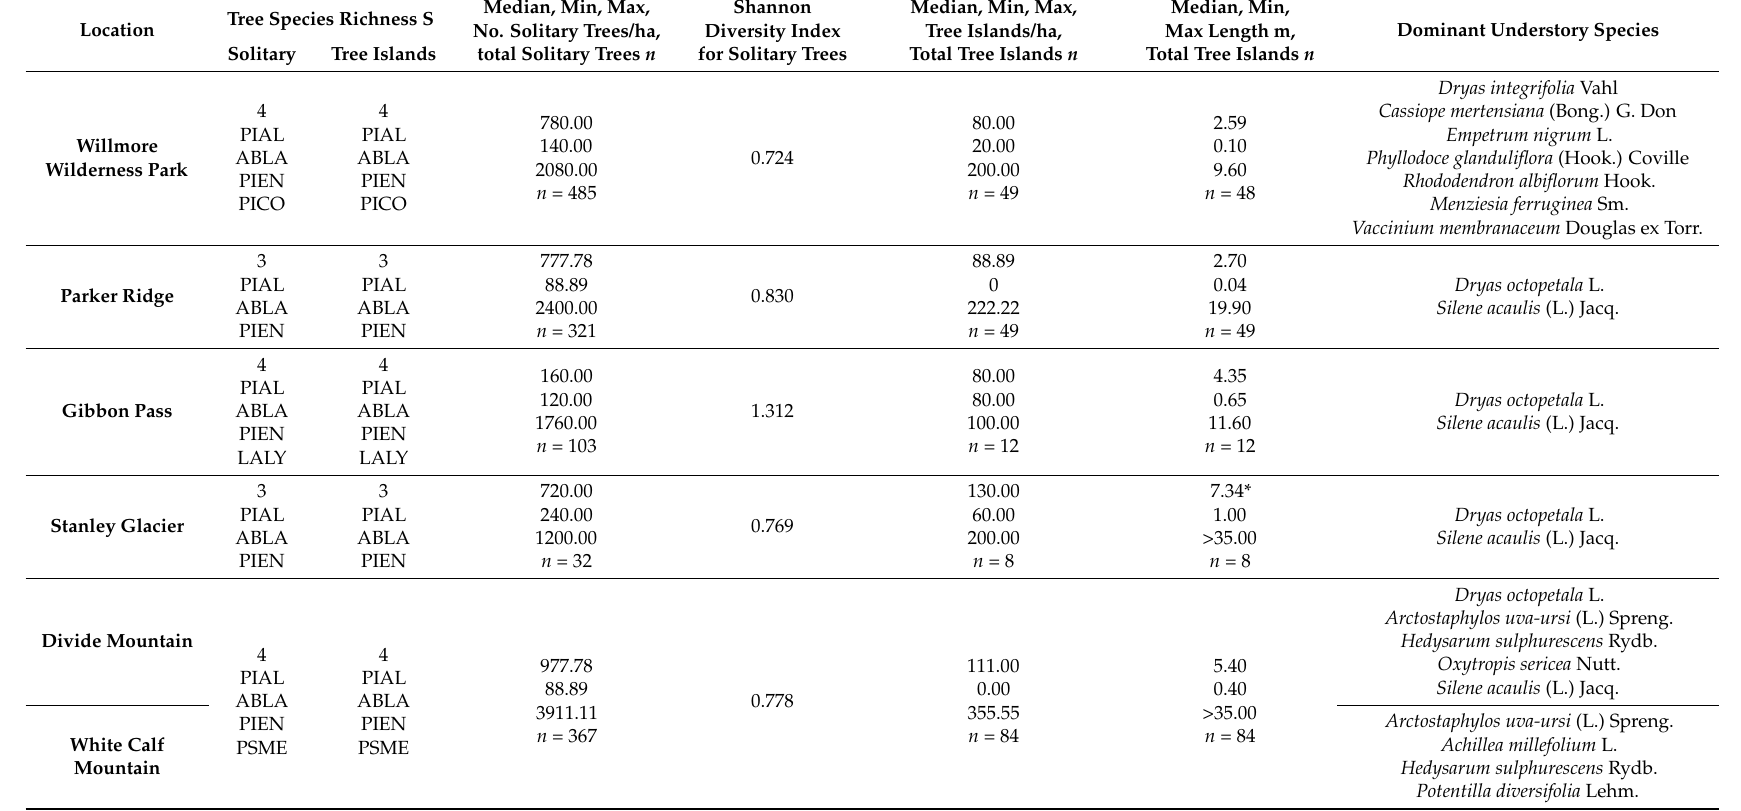
Table 3. Tree species richness, conifer composition, solitary tree density and tree island density, tree island length, and understory dominants for the ten study areas listed in Table 2. Conifer abbreviations are as follows: PIAL = whitebark pine ( Pinus albicaulis ), ABLA = subalpine fir ( Abies lasiocarpa ), PIEN = Engelmann spruce ( Picea engelmannii ), PICO = lodgepole pine ( Pinus contorta ), LALY = alpine larch ( Larix lyallii ), and PSME = Douglas-fir ( Pseudotsuga menziesii